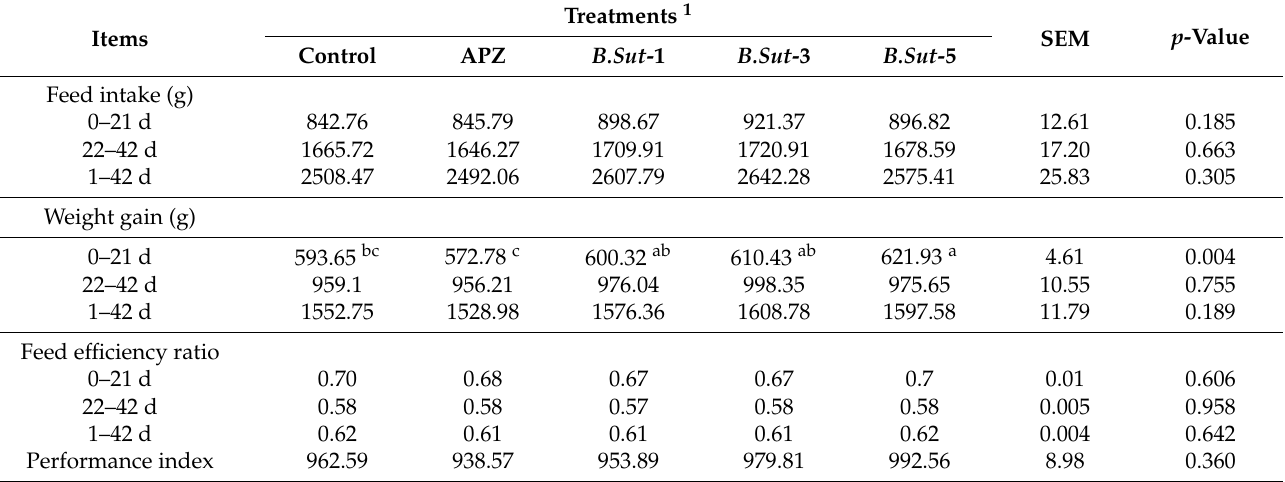
Table 1. Effect of the addition of Bacillus subtilis into broiler diets on broilers’ growth